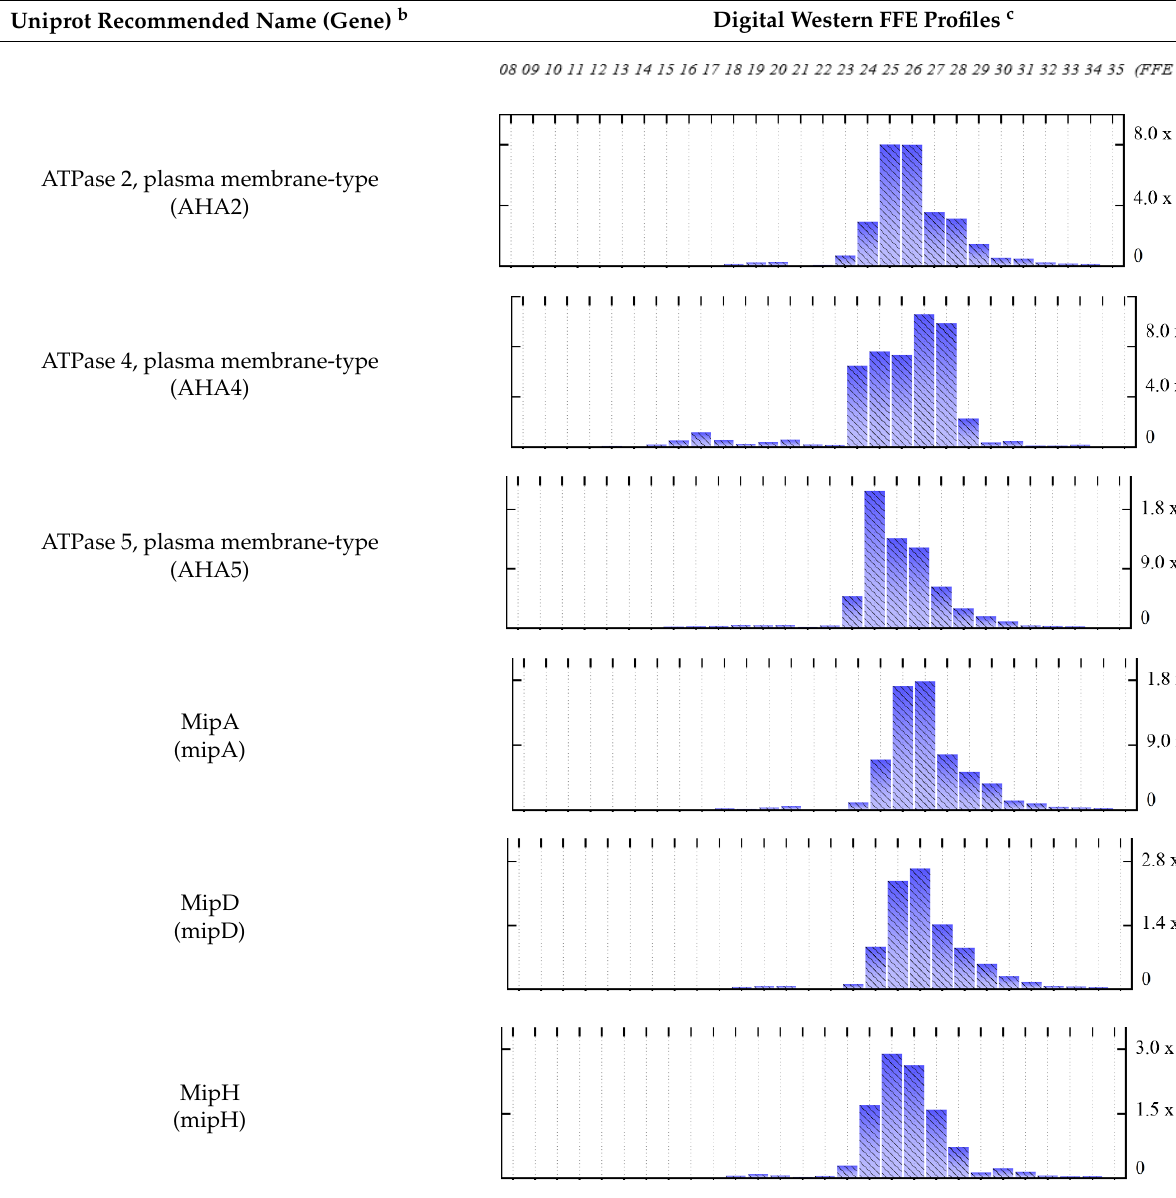
Table 6. Digital western FFE profiles of plasma membrane markers a .